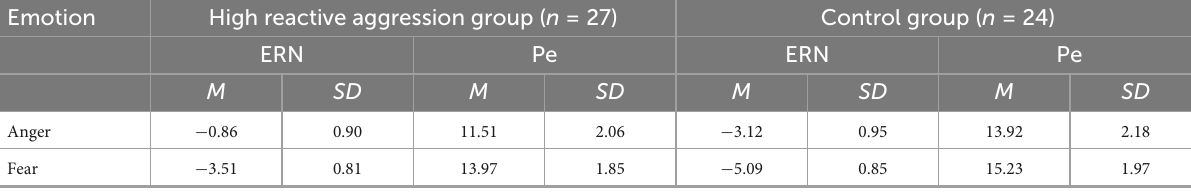
TABLE 3 Error-related negativity and error-related positivity amplitudes during the emotional Go/No-Go task by the group.